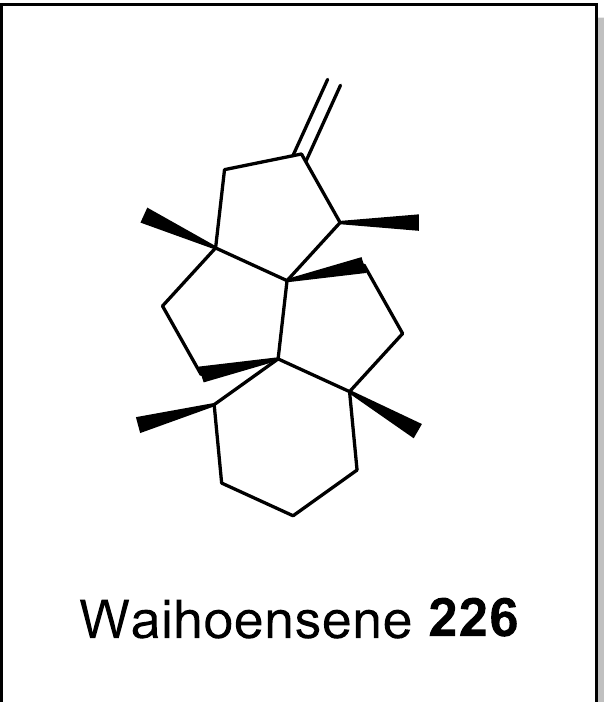
Figure 4. Structure of waihoensene 226 .